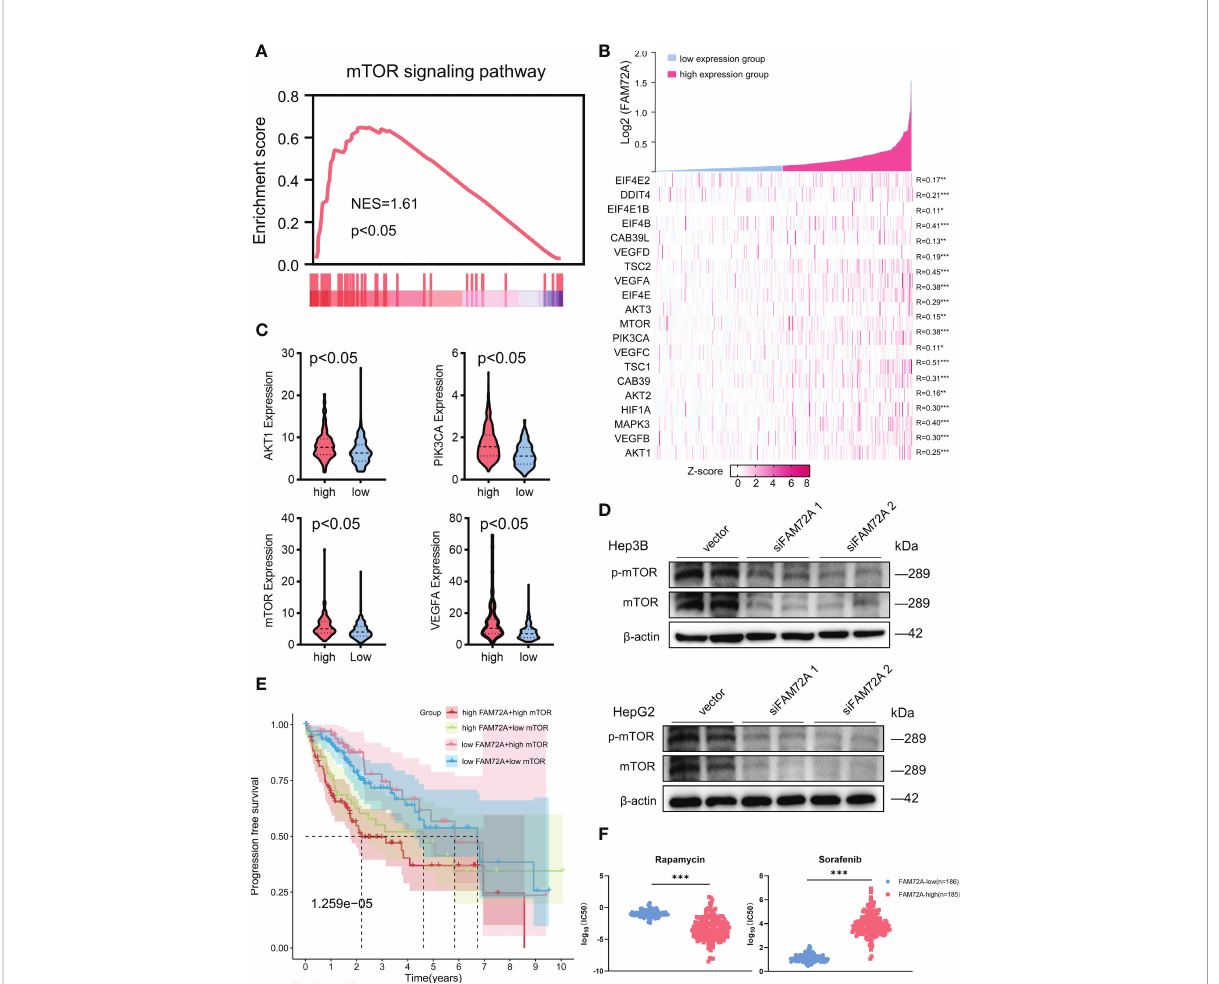
FIGURE 6 Analysis of the potential relationship between FAM72A and the mTOR axis in HCC. (A) Signi fi cant enrichment of high FAM72A expression and mTOR signaling pathways. (B) Coexpression heatmap of FAM72A and key genes in the mTOR signaling pathway. Statistical analyses were performed using the Spearman correlation test. (C) Gene expression levels (AKT1, PIK3CA, mTOR, and VEGFA) in the groups with high and low FAM72A expression. Statistical analyses were performed using the Wilcoxon test. (D) Western blot analysis of the relationship between FAM72A and mTOR protein levels in Hep3B and HepG2 cell lines after FAM72A was knocked down. Experiments were repeated three times. (E) Survival analysis of individuals with different expression levels of mTOR and FAM72A. Statistical analyses were performed using the log-rank test. (F) Differences in drug sensitivity between the high and low FAM72A expression groups. Statistical analyses were performed using the log-rank test. NES, normalized enrichment score; HCC, hepatocellular carcinoma; IC50, half-maximal inhibitory concentration. *p < 0.05, **p < 0.01, and ***p <